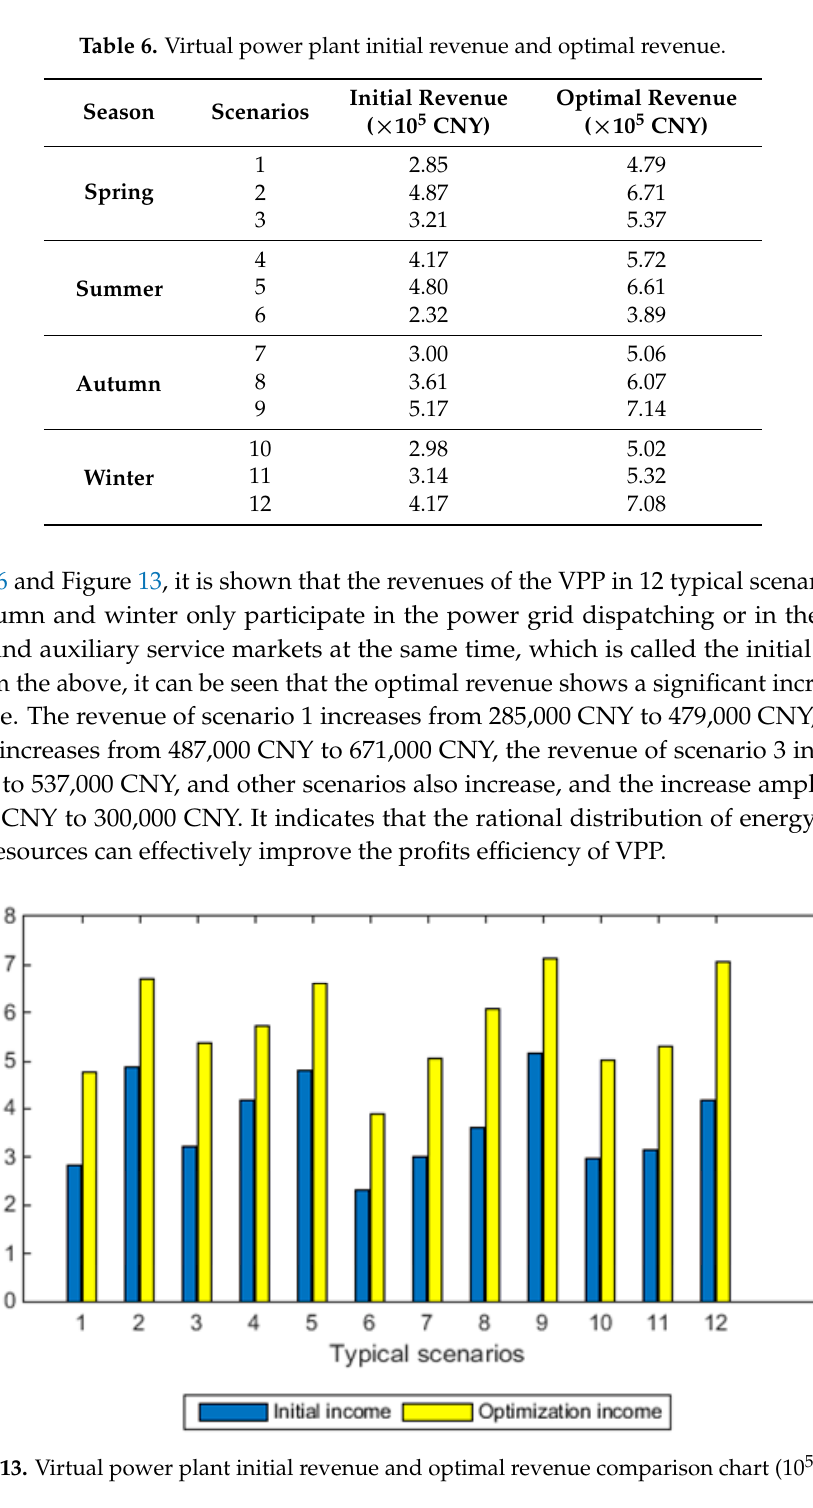
Table 7. The revenue of VPP of typical scenario 13.